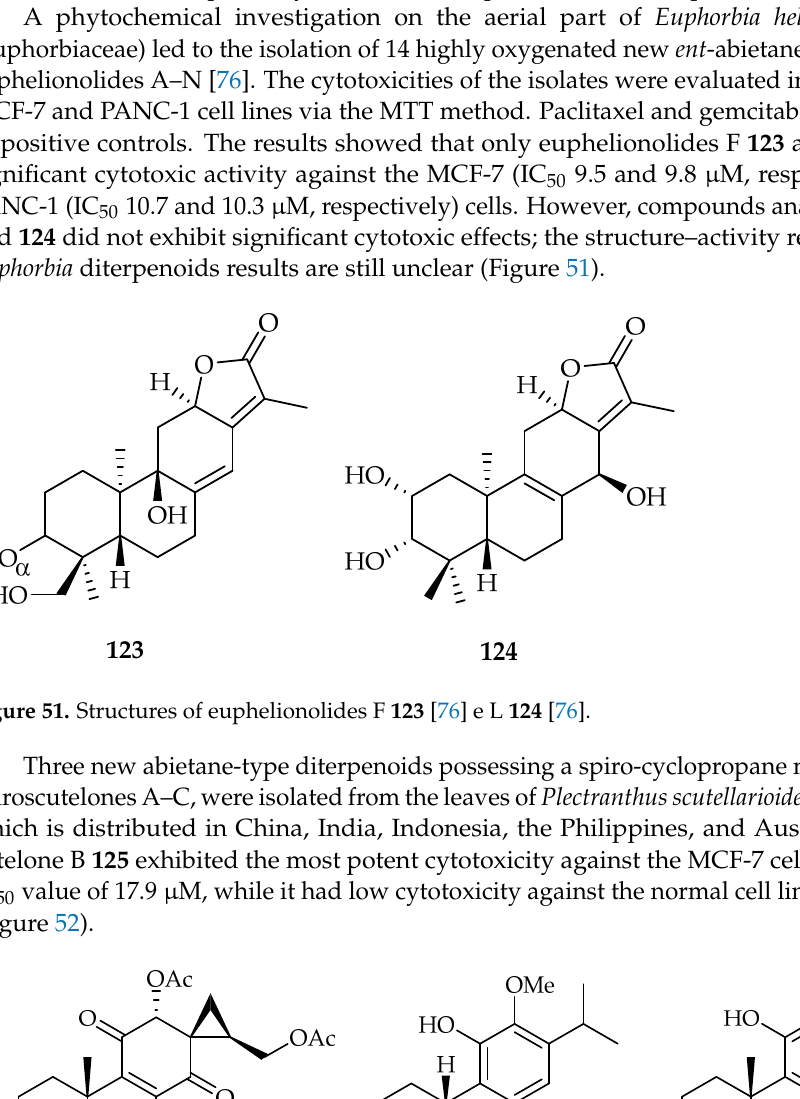
Figure 52. Structure of spiroscutelone B 125 [77], cuceolatin D 126 [78], and metaglyptin A 127 [79]. One new abietane-type diterpene was isolated from the leaves of Cunninghamia lanceolata (LAMB.) HOOK. (Taxodiaceae), an evergreen arbor mainly distributed in the regions south to the Yangtze River of China [78]. The new compound 126 , named cuceolatin D, showed significant cytotoxicity against the MDA-MB-231, MCF-7, and HeLa cell lines, with IC50 values all below 5 µ M, using the MTT method and doxorubicin as a positive control (Figure 52).